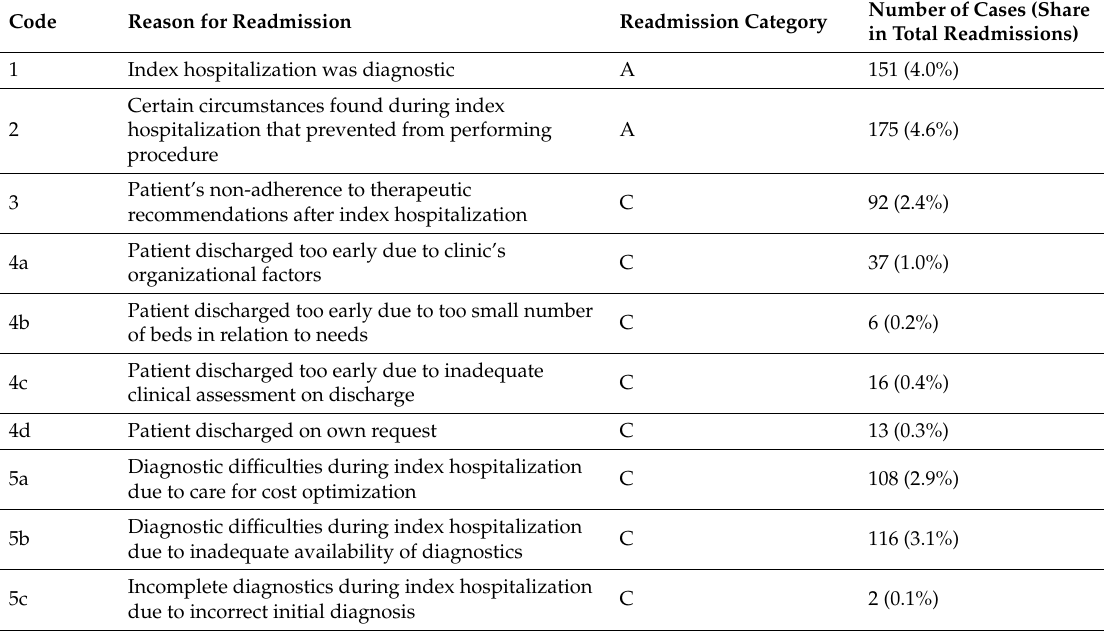
Table 3. Reasons for readmissions according to their status in terms of planning and relation to index